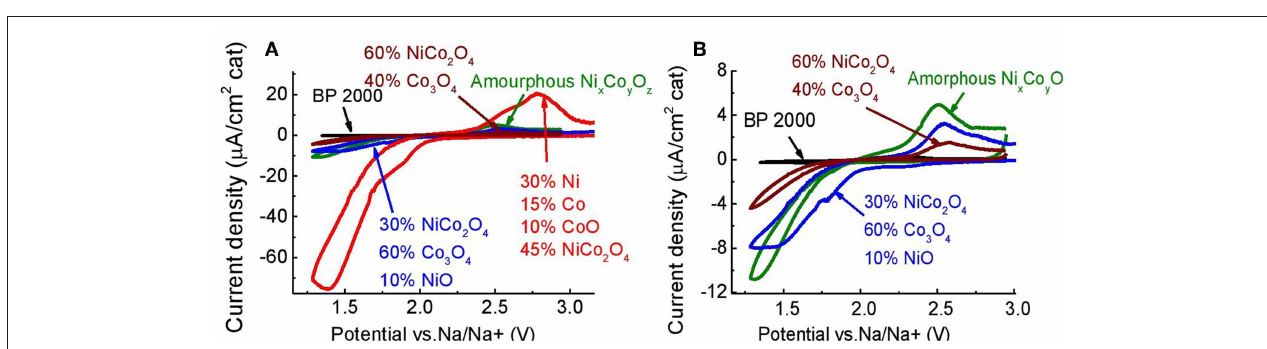
FIGURE 6 | (A) CV of BP 2000, and four synthesized Ni x Co y O z powders, coated on GC electrode (PEGDME500/0.25M NaOTf, Scan rate 5 mV/s), (B) magnified view of two synthesized Ni x Co y O z powders and BP 2000.